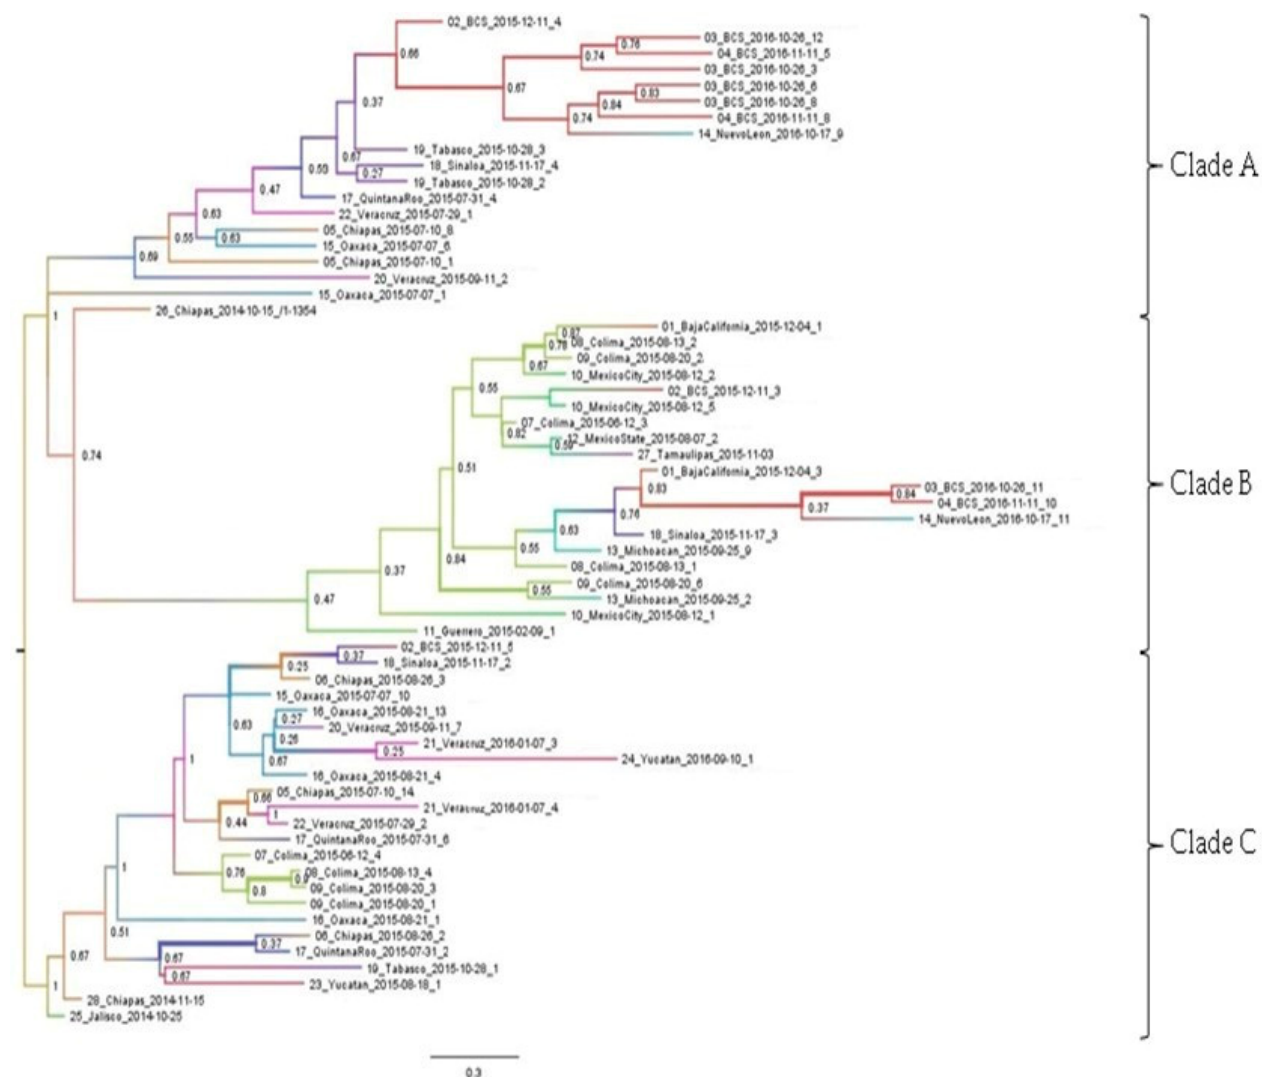
Figure 1. Maximum clade credibility phylogeny constructed with the 59 CHIKV sequences collected in this study along with the four sequences obtained at the beginning of the outbreak and 48 se- quences from other parts of the world. Taxon labels include accession number, isolation place, and year. The sequences collected in this study are shaded in grey. BPP values are shown for relevant nodes. The three clades identified in this study are magnified within bounded rectangles.